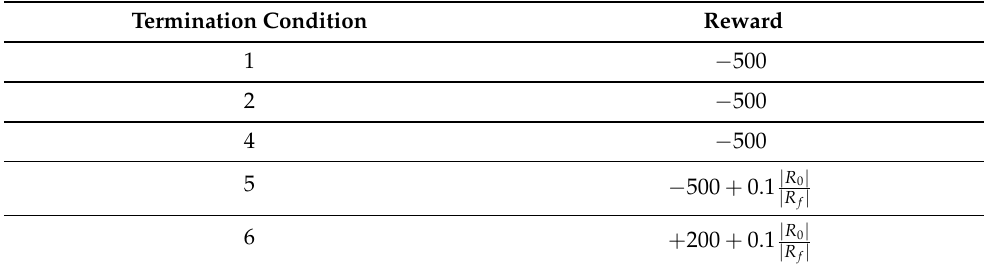
Table 7. Termination rewards for scenario A.